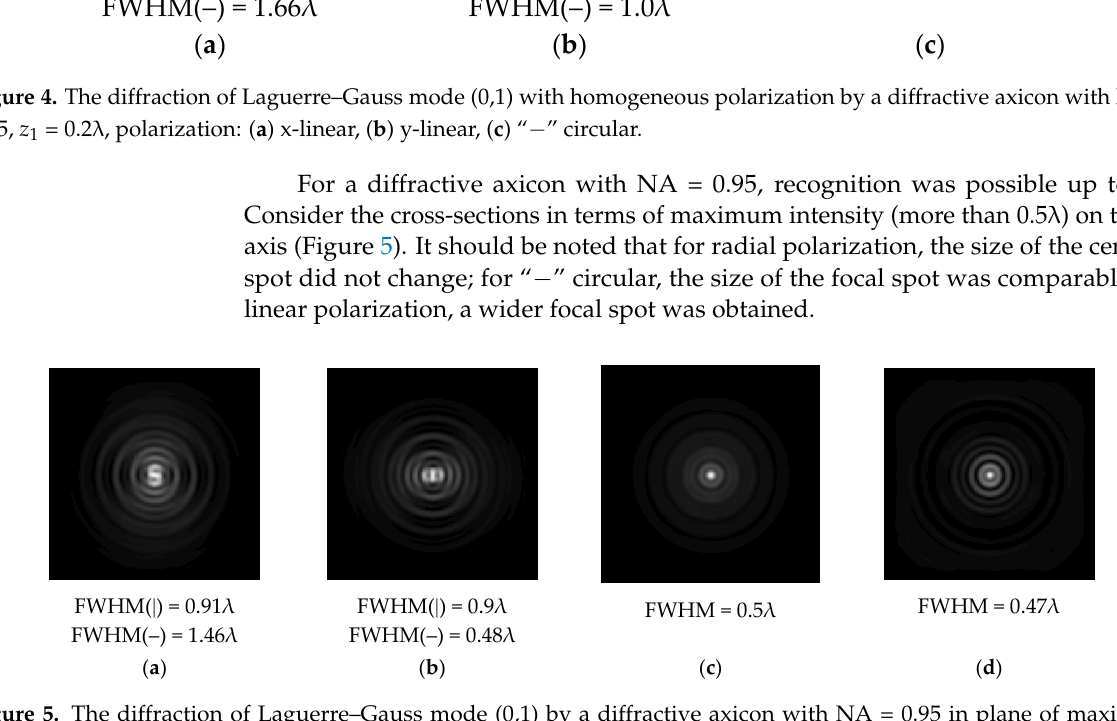
Figure 5. The diffraction of Laguerre–Gauss mode (0,1) by a diffractive axicon with NA = 0.95 in plane of maximum inten- sity, polarization: ( a ) x-linear, ( b ) y-linear, ( c ) “−” circular, ( d ) radial.